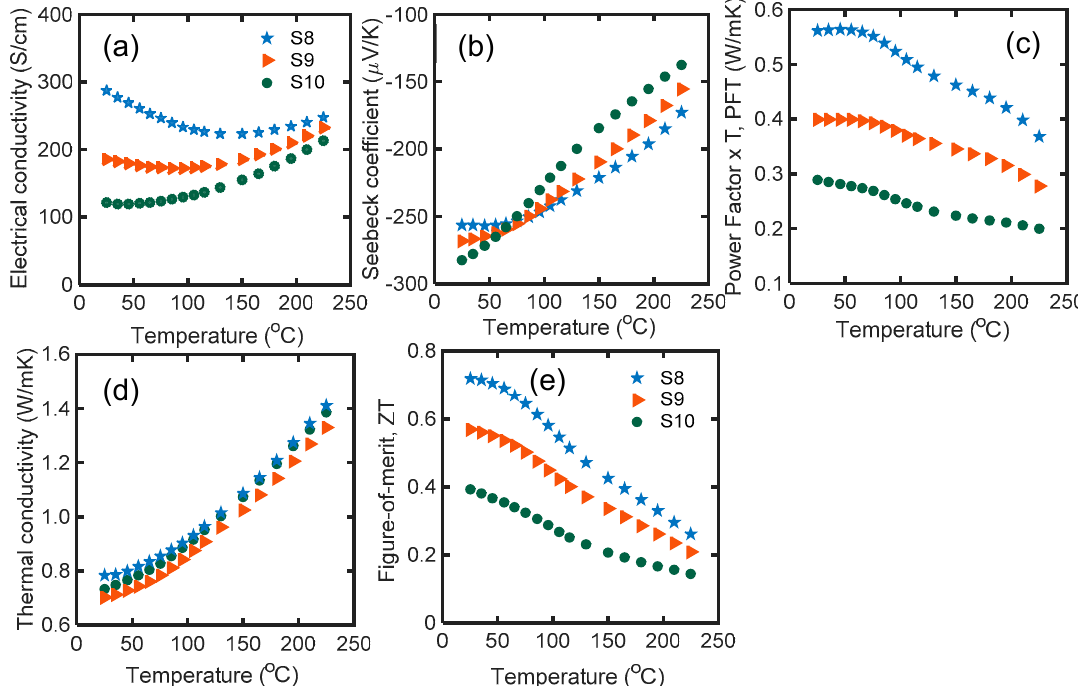
Figure 4. ( a ) Electrical conductivity; ( b ) Seebeck coefficient; ( c ) power factor times temperature (PFT); ( d ) thermal conductivity, and ( e ) zT of S6, S7, and S8 samples as a function of temperature in the range of 25 °C to 225 °C. A 2.5 at. % glass inclusion was added to Bi 2.0 Te 2.7 Se 0.3 . S6, S7, and S8 were sintered at 540 °C with 1, 2 and 3 min soaking time, respectively.